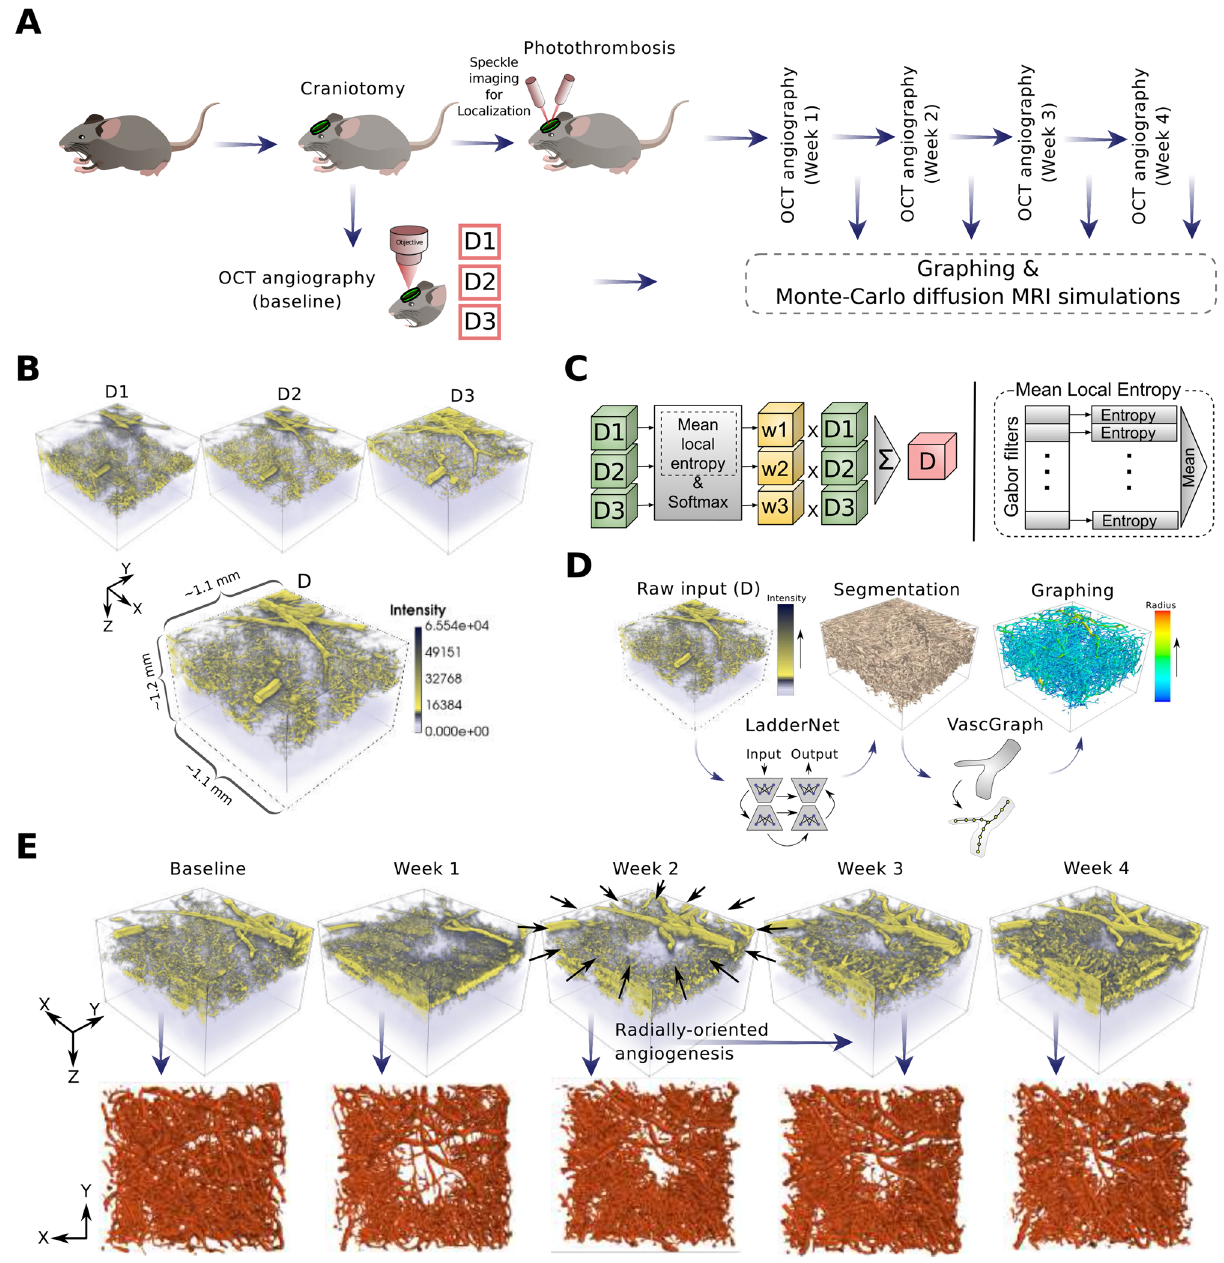
Figure 1. ( A ) Our experimental procedure for inducing and monitoring of micro-occlusions. Depth-dependant Pre- and post-lesion OCT angiographic acquisitions were preformed to capture vascular degeneration. The OCT stacks acquired at different time points are fed to our computational pipeline to study differences in their diffusion MRI response. ( B ) Reconstruction of a final 3D OCT angiogram D from three depth-dependent images, namely, D1, D2 and D3. ( C ) Our technique of reconstructing D is based on taking the weighted sum of D1, D2 and D3. The associated weights are determined by the mean local entropy calculated from D1, D2 and D3 after processing them with a set of Gabor filters. The image with richer vascular structures contributes more to the weighted sum. ( D ) Our image processing pipeline used to extract useful structural/topological models of vascular networks. These models are essential to perform our Monte-Carlo MRI simulations. The segmentation is based on a customly trained LadderNet architecture. We used The VascGraph toolbox 21 to obtain graph-based vascular skeletons that can approximate the needed anatomical information. ( E ) 3D rendering of the vascular structure before and after creating a photothrombotic lesion. A noticeable radial-wise orientation is observed after-lesion especially following Week 2. The mouse image in ( A ) is reproduced from 55